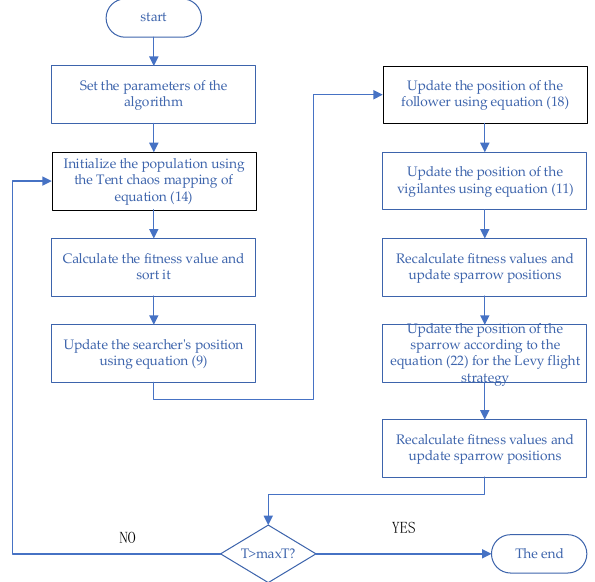
Figure 4. Flowchart of the CISSA algorithm.